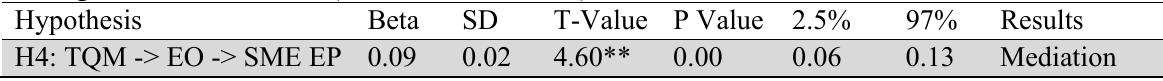
Findings of structural model (Indirect effect results) Hypothesis Beta